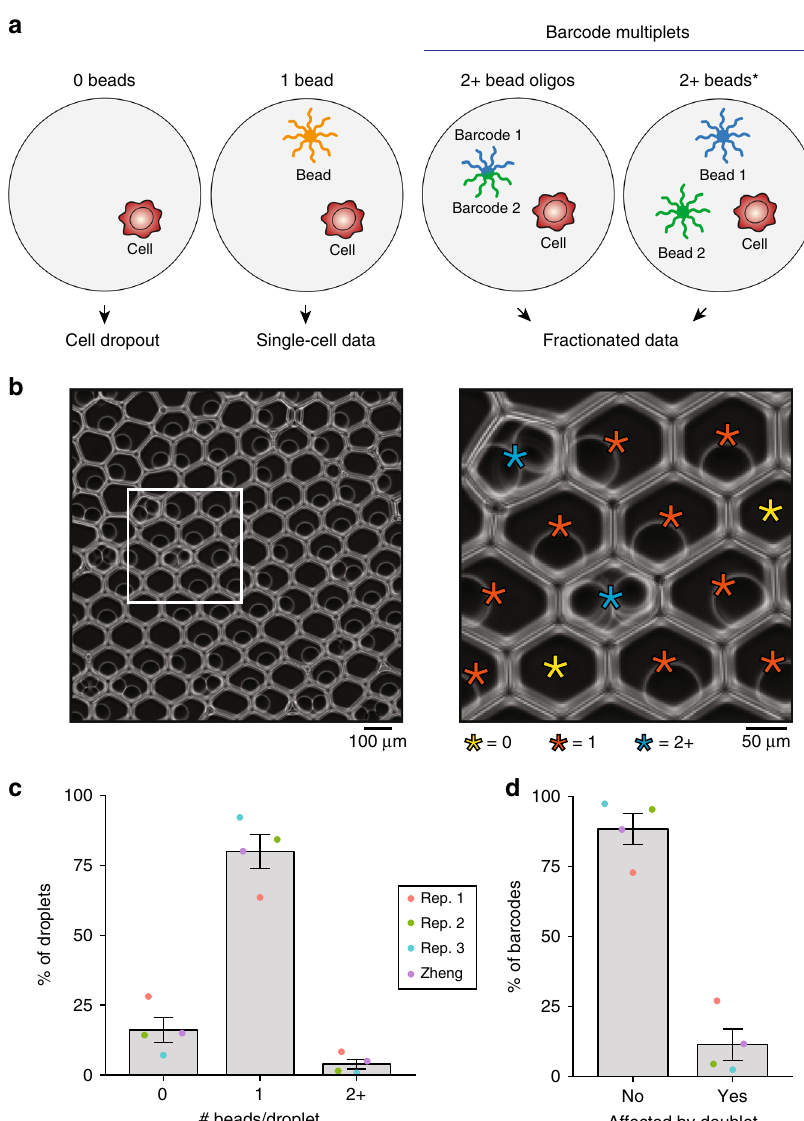
Fig. 1 Quanti fi cation of barcode multiplets from multiple beads in 10× Chromium platform. a Schematic of bead loading variation and phenotypic consequences. Droplets with 0 beads fail to pro fi le nucleic acid from the loaded cell ( “ dropout ” ) whereas barcode multiplets fractionate the single-cell data. Barcode multiplets can be generated by either heterogeneous barcodes on an individual bead or two or more beads loaded into the same droplet. The * indicates the bead multiplet that can be quanti fi ed via imaging. b Representative example of beads loaded into droplets from the 10× Chromium platform. The white box is magni fi ed 3× for the panel on the right, revealing multiple beads loaded into droplets. Stars indicate beads (except 0) and are colored by the number of beads contained in the droplet. The image is representative of a total of 30 fi elds of view taken from three independent experiments. c Empirical quanti fi cation of number of bead barcodes based on image analysis over 3 replicates with previously published data (Zheng et al. 2 ). d Percent of barcodes associated with multiplets under the distribution observed in c . Error bars represent standard error of mean over the experimental replicates. Source data are available in the Source Data fi